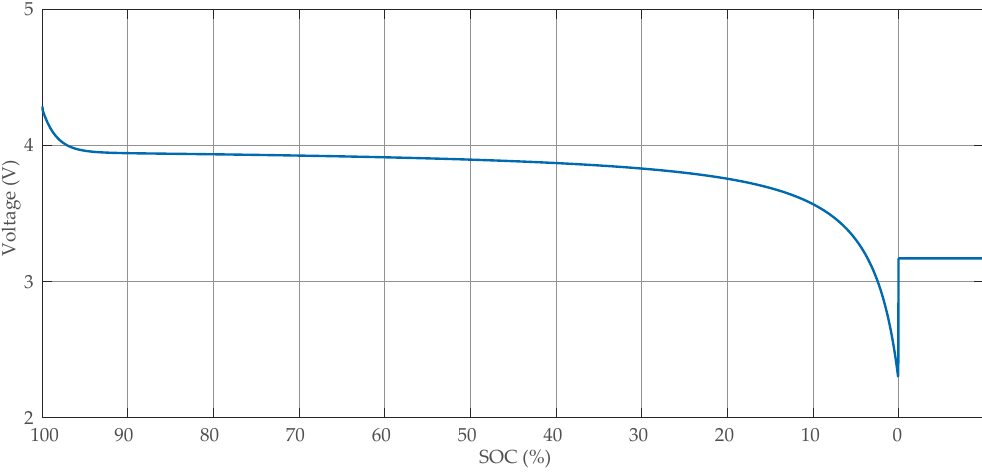
Figure 12. Behaviour of the capacitance C 1 for a Li-Po cell according to the V OC , V (cid:48) the R 1 value.